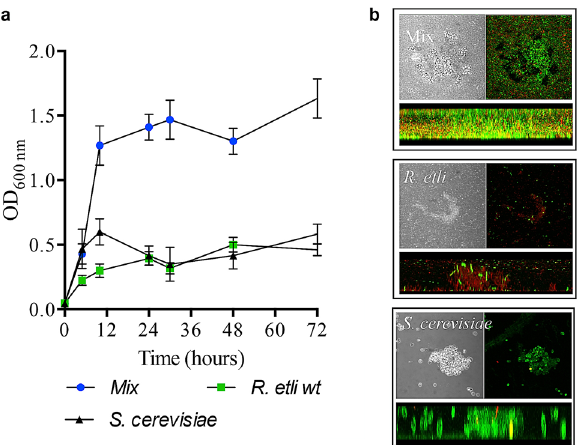
Figure 1. The interaction between S. cerevisiae and Rhizobium etli CE3 results in the formation of a structurally complex and more productive biofilm in terms of biomass. ( a ) Biofilm formation of R. etli CE3 and S. cerevisiae Σ1278h Mat α and biofilm growth over time in minimal dextrose medium. The data are representative of 3 independent experiments +/− the S.D. values. ( b ) Top view and cross section of confocal micrographs of the S. cerevisiae-R. etli mixed biofilm and the single-species biofilms. Magnification 40 × . The images are representative of 3 independent experiments. Biofilms were developed on glass microscope slides and stained with a LIVE/DEAD viability kit. Red fluorescence indicates dead cells, and live cells are colored green. Images were acquired 24 h after